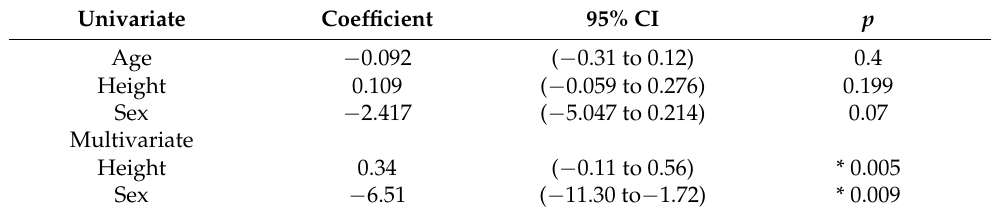
Table 3. Results of the univariate linear regression analysis; * p < 0.05. confidence intervals (CI).